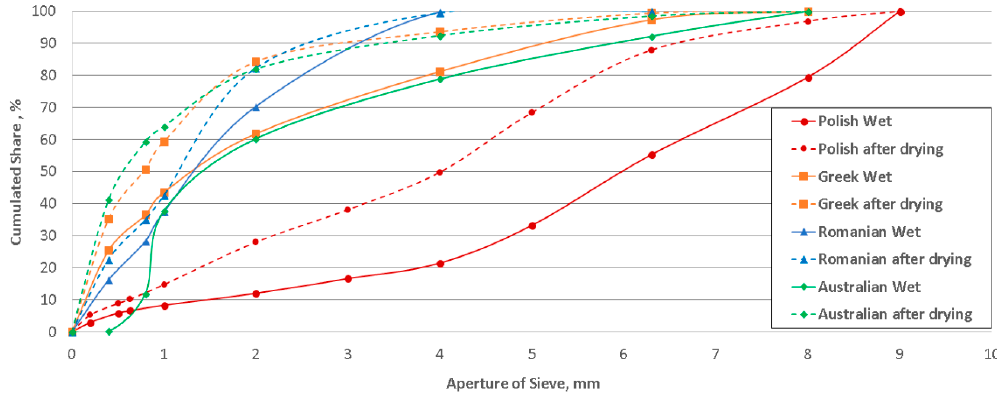
Figure 4. Particle size distribution of lignite of various origin before and after drying in the Torbed installation.